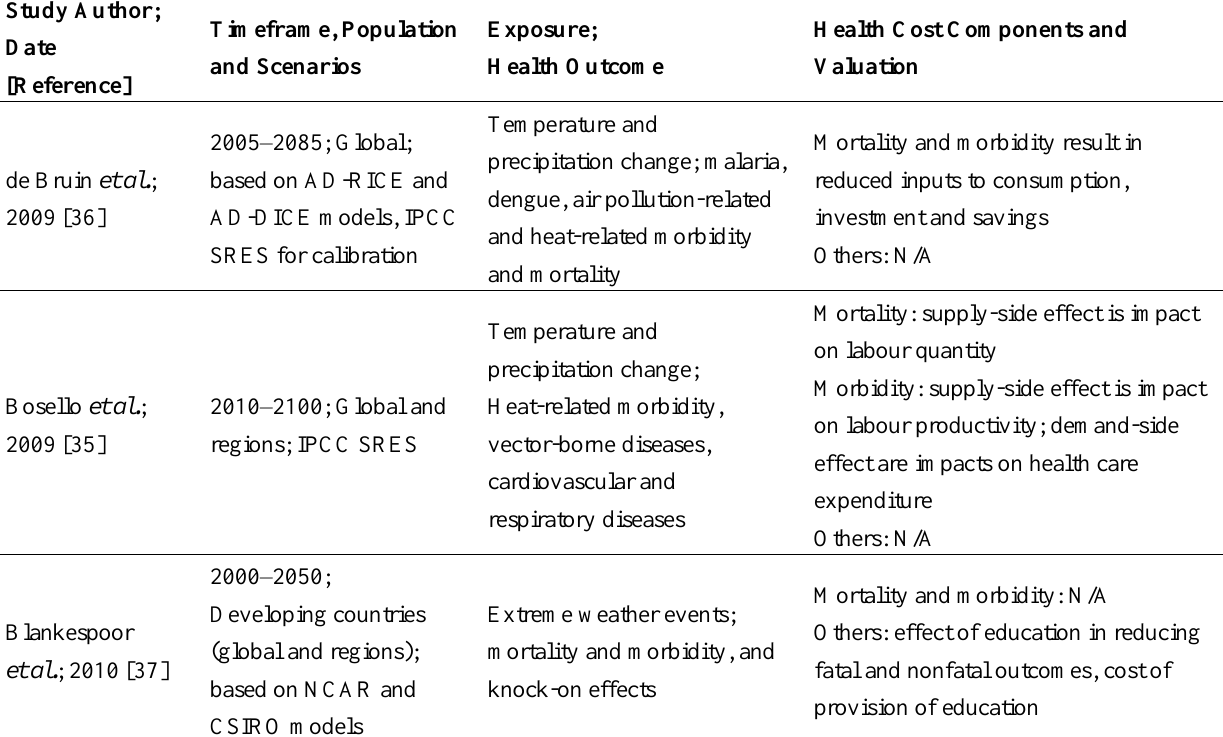
Table 4. Studies estimating economy-wide impacts of inaction or health